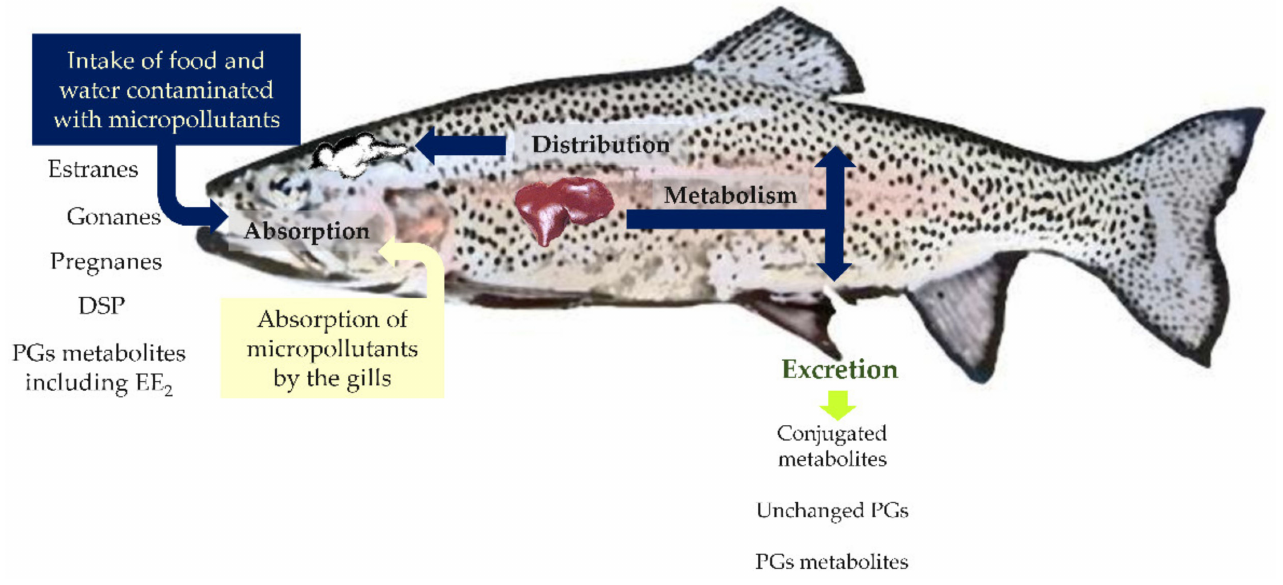
Figure 4. Routes of entry, circulation, major places of action, and the fate of progestins such as pregnanes, estranes, gonanes, spironolactone derivatives, and other